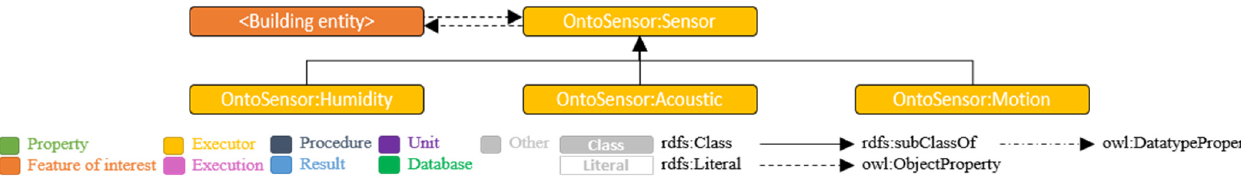
Figure 9. The absence of properties in OntoFM.